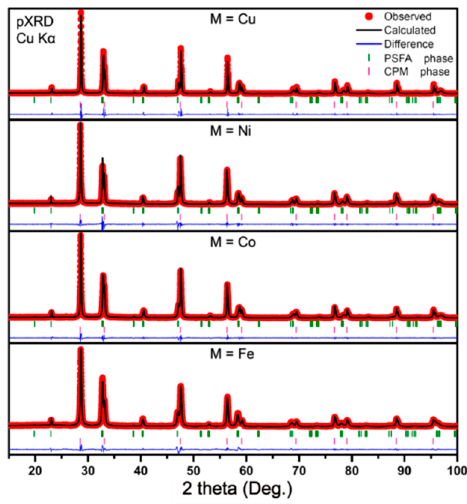
Figure 1. X-ray powder diffraction (XRD) refinements for CPM-PSFA (M = Fe, Co, Ni, Cu) powders after calcined at 950 °C for 10 h in air, respectively.